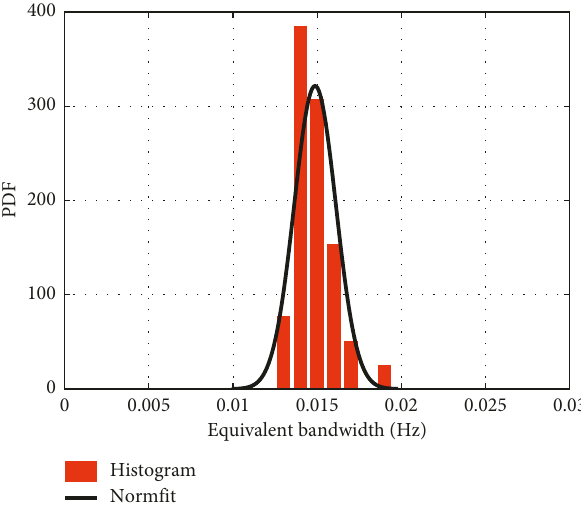
Figure 10: Equivalent bandwidth distribution for all participants at 1.8 Hz for the reference configuration.